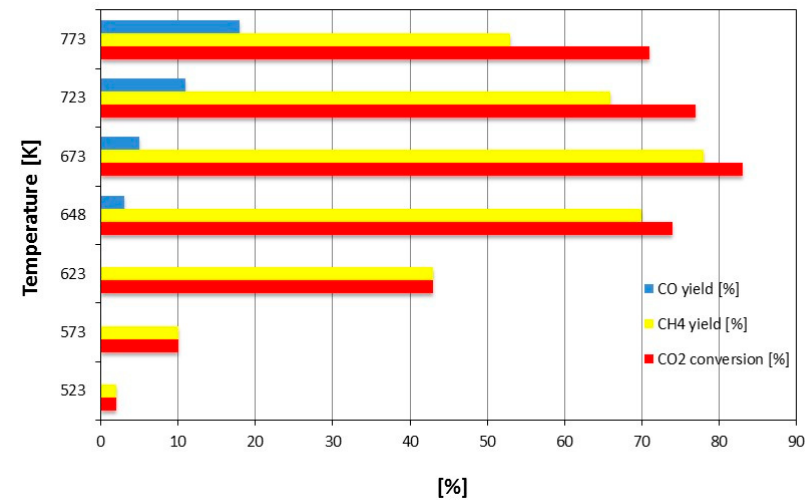
Figure 4. CO 2 conversion, CH 4 and CO yields on pre ‐ reduced 3%Ru/Al 2 O 3 catalyst and GHSV = 55000 h − 1 , at different temperature reactions. Adapted from Garbarino et al.